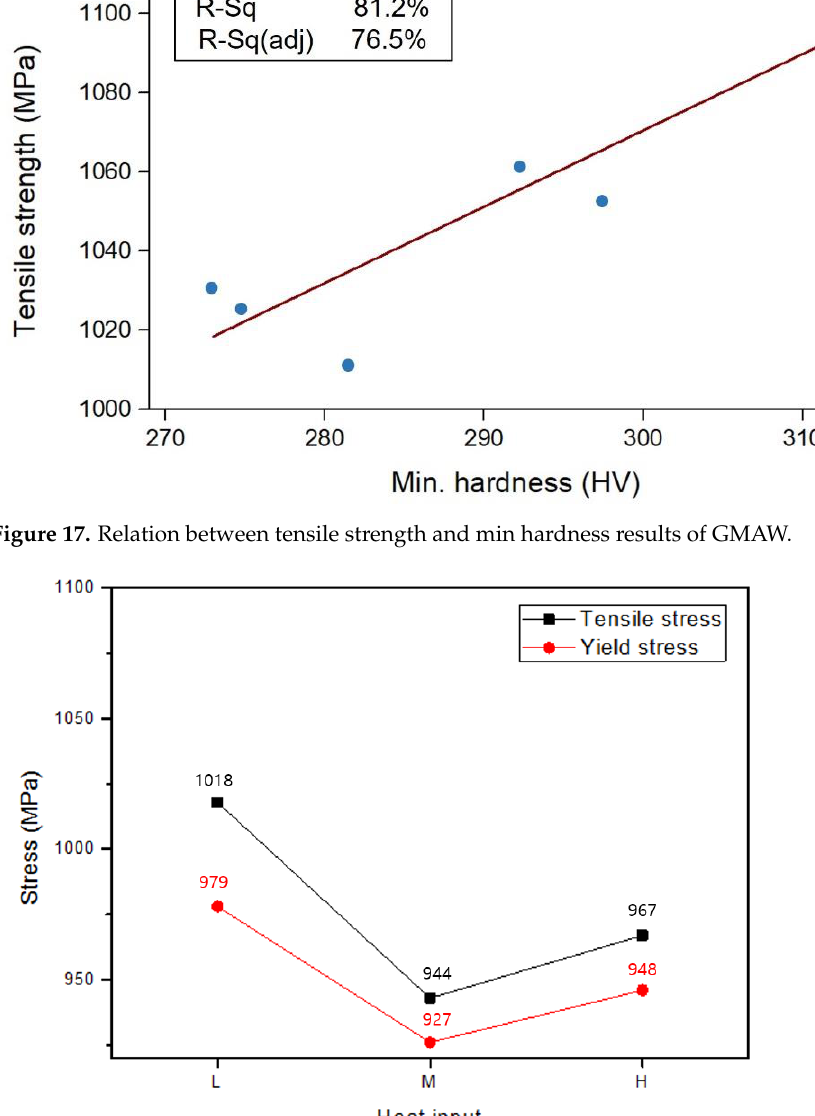
2 100% shielding gas and heat